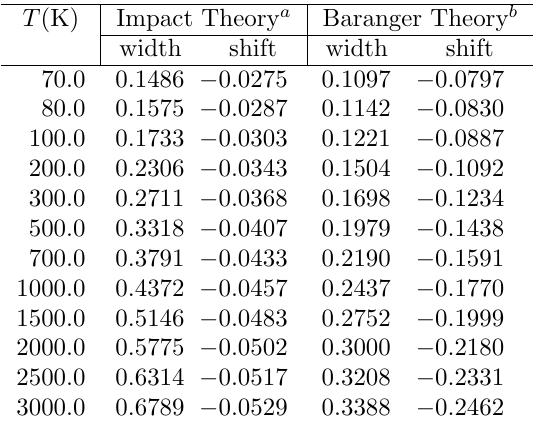
Table 7. Transition Na 3p 2 P{3s 2 S at 589.36 nm broadened by helium. Half half-widths w=N and shifts d=N (in units of 10 (cid:0) 21 MHz m 3 /atom = (2 (cid:25) ) (cid:0) 1 (cid:2) 10 (cid:0) 9 rad s (cid:0) 1 cm 3 /atom) a